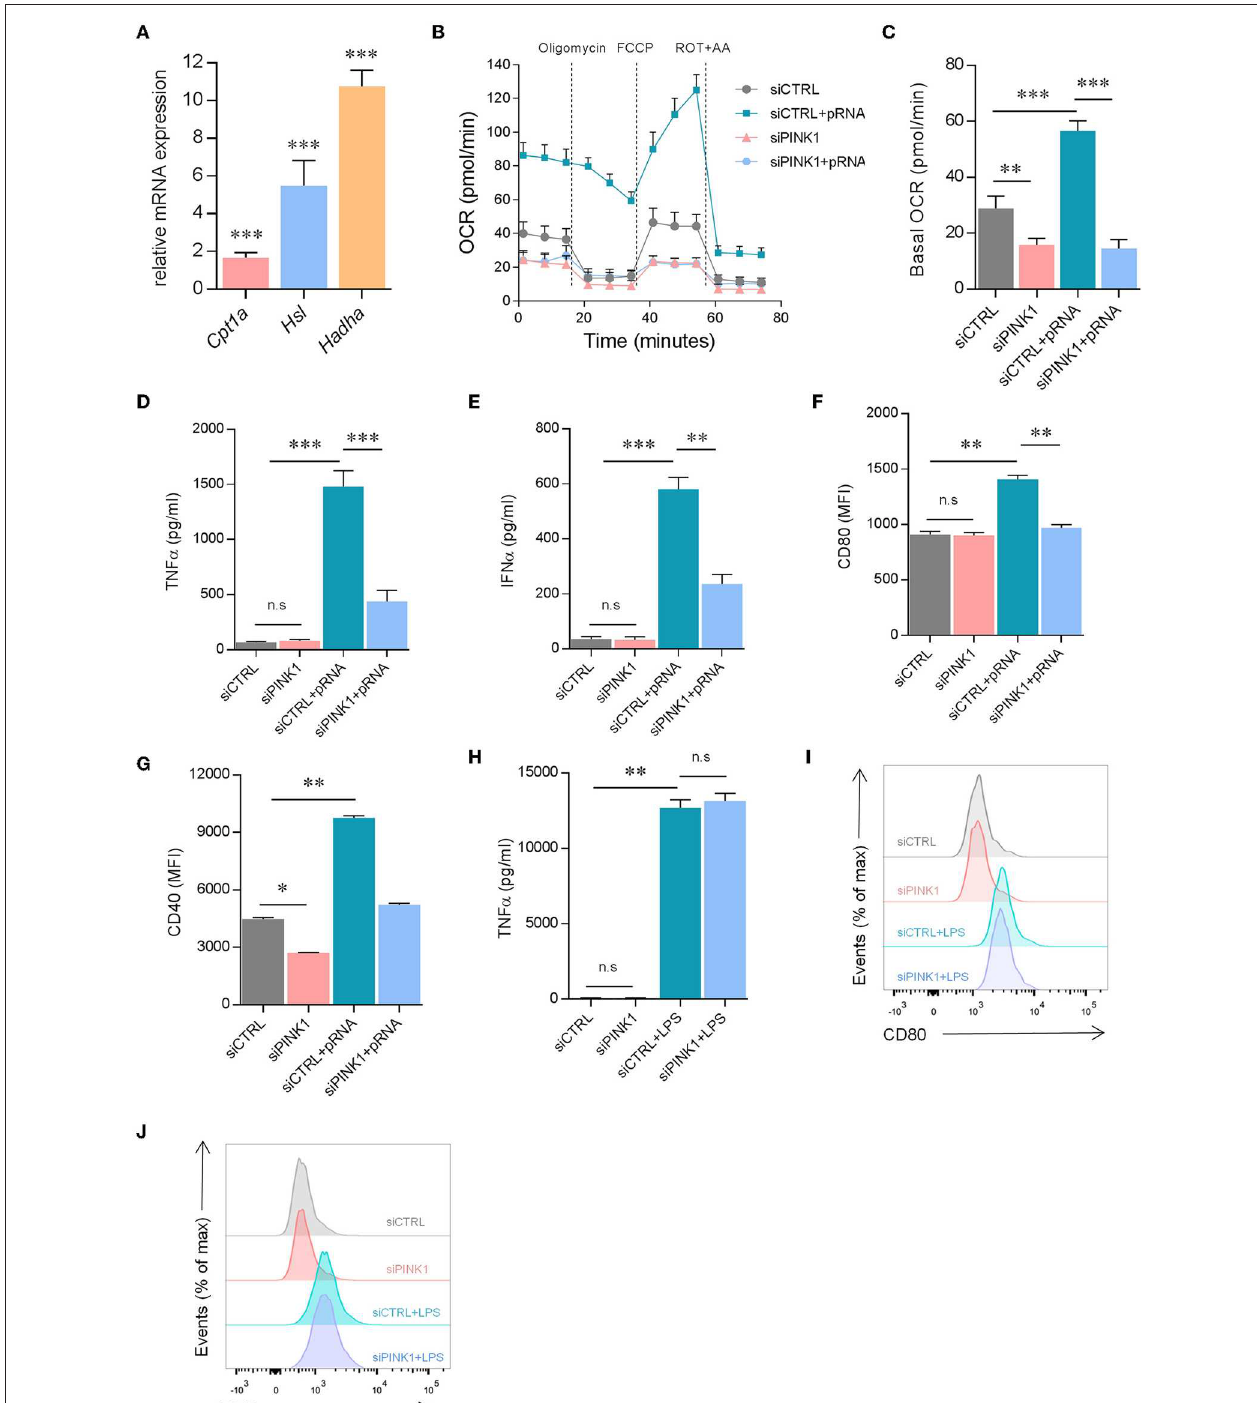
FIGURE 4 | pRNA-stimulated DC maturation requires PINK1-dependent FAO. (A) Relative mRNA levels were analyzed after 12h of pRNA stimulation by (qPCR) and normalized to β -actin expression by using the 2 11 CT method. Data represents Mean ± SEM of three independent experiments performed in triplicate. *** p < 0.001 (two-way ANOVA). (B) OCR was measured in DCs cultured in substrate-limited medium to indicate oxidation of endogenous fatty acids. Quantification of total FAO as the difference between conditions with or without Etomoxir treatment is shown. Data represents mean ± SEM of three independent experiments two-way